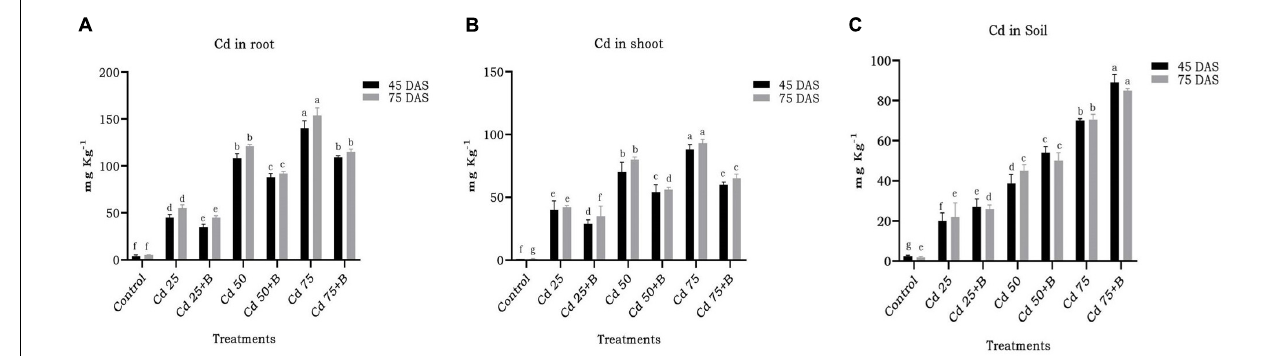
FIGURE 8 | Effect of the application of Ochrobactrum intermedium BB12 on the uptake of Cd by the root (A) and shoot (B) of spinach plants grown in the soil containing 25 (Cd25), 50 (Cd50), and 75 (Cd75) mg kg − 1 metal concentration at 45 and 75 days of sowing (DAS). Cd content in the soil measured at the same time interval is shown in panel (C) . B denotes the treatment containing bacteria O. intermedium . Values are the means ( ± SD) of three replicates; within the same column with different letters, values are significantly different at p ≤ 0.05 in DMRT. SD, standard deviation. “a” stands for highest variation, followed by “b” and lowest by “f” from the experimental